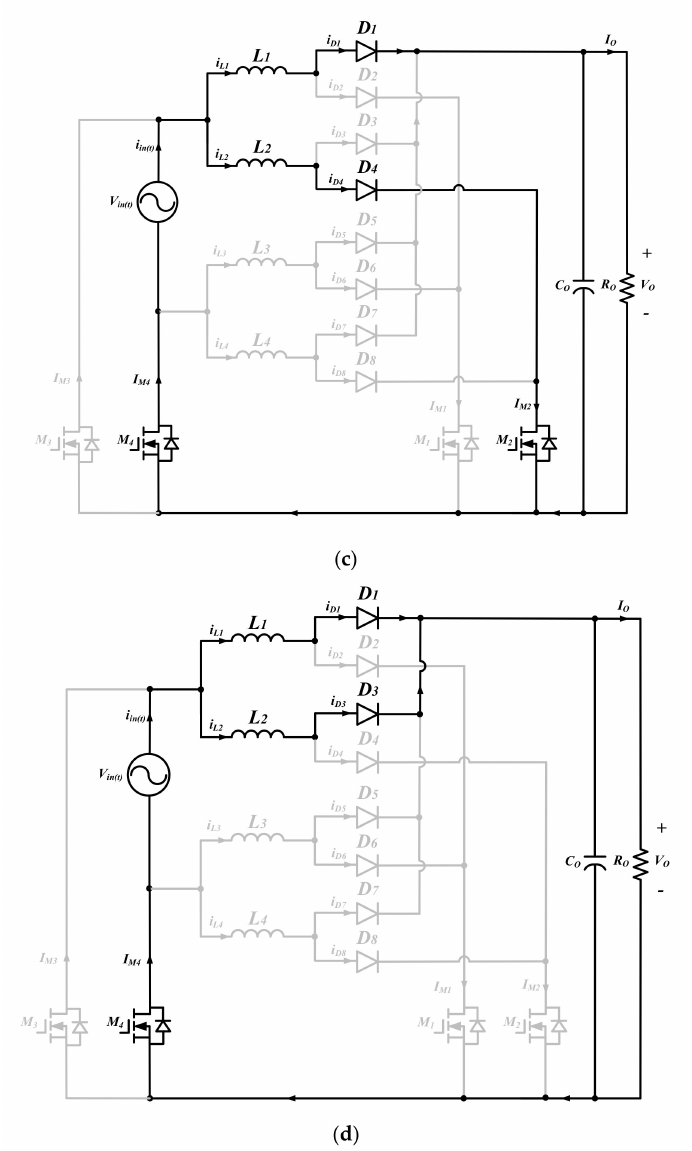
Figure 8. Equivalent circuit of the proposed interleaving bridgeless boost converter operated in the positive half period over one switching cycle. ( a ) Mode 1 ( t 0 ≤ t ≤ t 1 ), ( b ) Mode 2 ( t 1 ≤ t < t 2 ), ( c ) Mode 3 ( t 2 ≤ t < t 3 ), ( d ) Mode 4 ( t 3 ≤ t < t 4 ). Mode 1 (Figure 8a: t 0 ≤ t < t 1 ): Before t 0 , inductors L 1 and L 2 simultaneously work in the released energy states. Diodes D 1 and D 2 are forwardly biased. Currents i L 1 and i L 2 linearly decrease through D 1 , load R 0 and switch M 4 , and D 3 , load R 0 and switch M 4 , respectively. When t = t 0 , switch M 1 is turned on and M 4 is kept in a turned-on condition. Diode D 1 is reversely biased and D 2 is forwardly biased, and inductor L 1 enters the stored energy state. In addition, inductor L 2 works in the released energy state through diode D 3 . During this interval, inductor current i L 1 linearly increases and current i L 2 linearly decreases. Mode 2 (Figure 8b: t 1 ≤ t < t 2 ): At t 1 , switch M 1 is turned off and M 2 is still in a turned-off state. Inductors L 1 and L 3 are in the released energy state through diodes D 1 , D 3 and switch M 4 , simultaneously. In this mode, currents i L 1 and i L 2 linearly